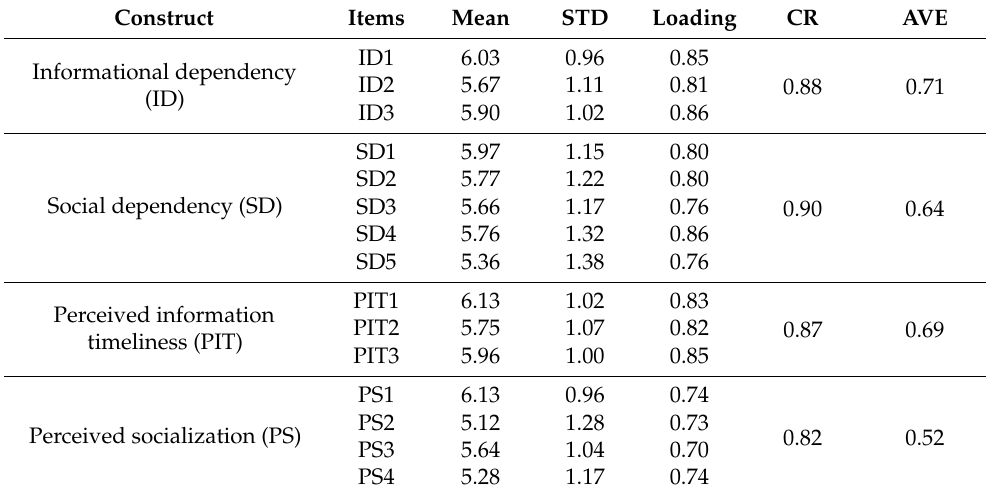
Table 2. Standard item